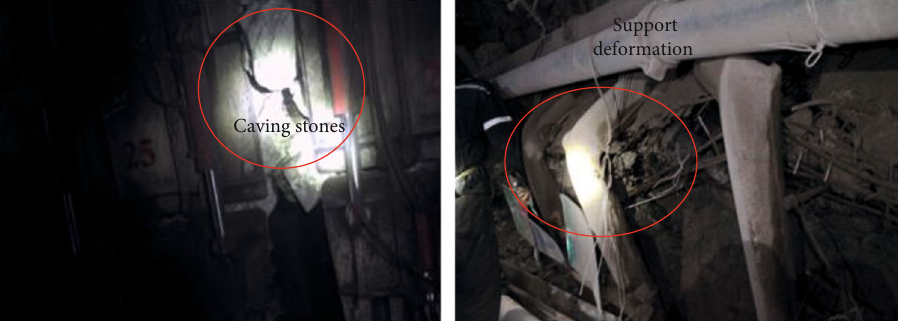
Figure 3: Photos from fi eld investigations.